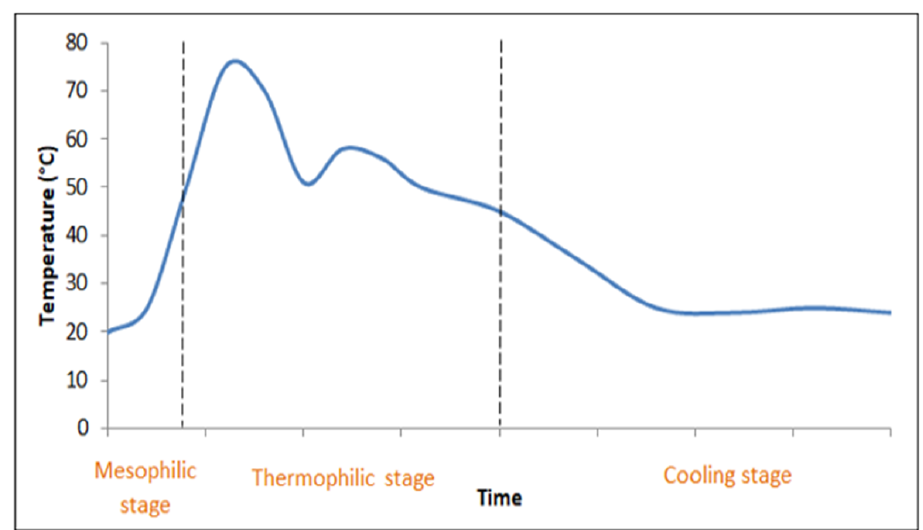
Figure 1. Temperature changes during composting (FAO